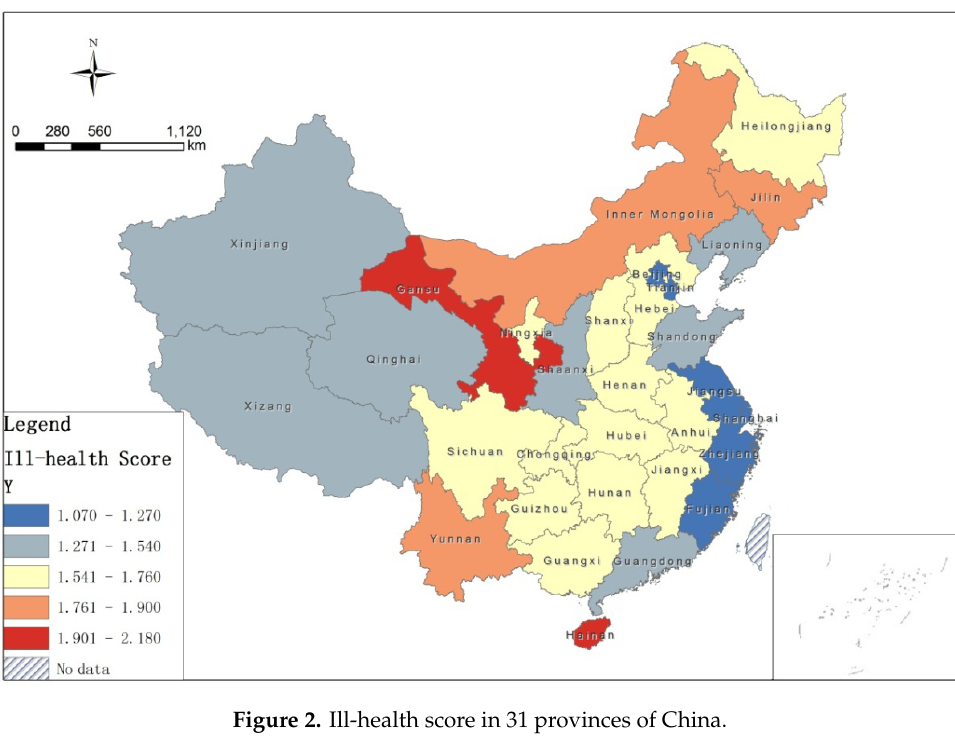
Figure 2. Ill-health score in 31 provinces of China.